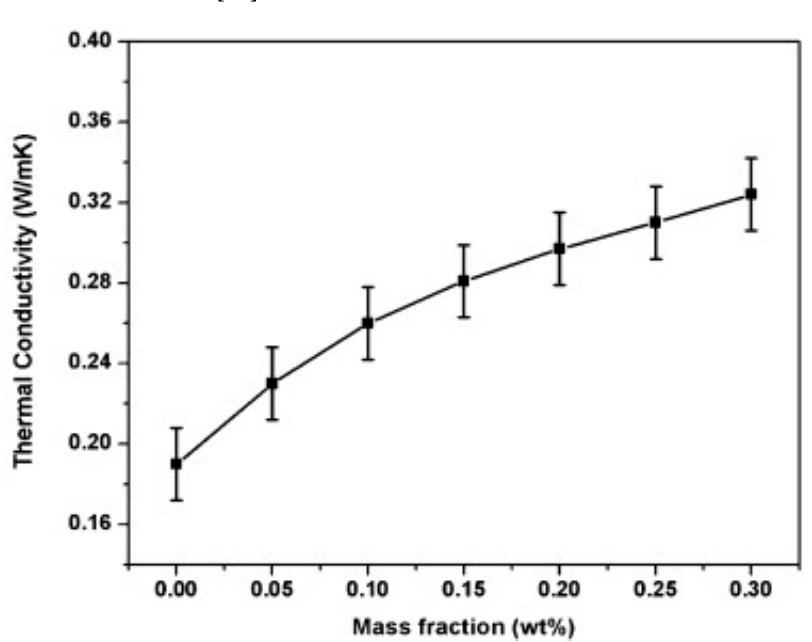
Figure 7. Thermal conductivity to mass fraction relationship for stearic acid-TiO2 NEPCM. (Reprinted with permission from ref. [27]. Copyright 2013 Thermochimica Acta).